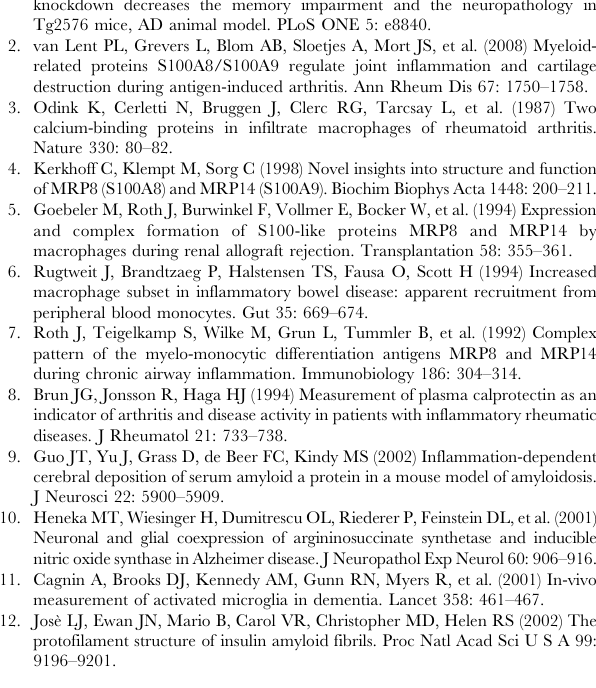
7.4 and 37 0 C for 3 d. The scale bars represent 500 nm, 1000 nm and 500 nm, respectively. (d) CD spectra of the corresponding samples shown in AFM: black squares correspond to Fig. (a); blue triangles correspond to Fig. (b); red circles correspond to Fig. (c). Figure S4 Measurements of NHSY5Y cell line viability by WST1 assay in the presence of (a): freshly dissolved A b 1–40 at pH 7.4. Different colors denote different concentrations of A b 1–40. (b): 0.2 mM A b 12–24 fibrils, 0.2 mM A b 1–40 fibrils and 0.2 mM A b 1–40 plaque. A b 1–40 plaques were formed by incubation at pH 3.0 and 37 0 C for 3 d. To avoid pH effect, pre-formed A b plaques were carefully dialyzed to pH 7.4. A b 12–24 and A b 1–40 fibrils were formed by incubation at pH 7.4 and 37 0 C for over 10 d. (c) The relationship between the kinetics of S100A9 amyloid formation (Relative ThT: left Y axis) at pH 3.0 and the effects of S100A9 (0.02 mM) on NHSY5Y cell viability (WST1 assay: right Y axis). Before mixing with cells, S100A9 was incubated at pH 3.0 and 4 0 C for up to 70 d. Aliquots were taken for measurements of ThT and cytotoxicity at different time during incubation. The columns in each group correspond to 1 to 3 d of incubation with cells (In day 6 aliquots, S100A9 samples were incubated with cell for up to 2 d). (d) Measurements of NHSY5Y cell line viability by WST1 assay in the presence of S100A9 (0.02 mM) at pH 7.4 and 3.0. Different colors denote 1 d to 3 d of incubation with cells. Figure S5 (a) Luminescent cytotoxicity assay of neuron cells in presence of 0.02 mM S100A9 and S100A9/A b 1–40 mixture. S100A9 and the mixture were incubated at 37 0 C for 3, 6, 12 and 24 h before mixing with cells. A b 1–40 plaques were formed by incubation at pH 3.0 and 37 0 C for 3 d. To avoid pH effect, pre- formed A b plaques were carefully dialyzed to pH 7.4 before mixing with S100A9. Utilizing cortical neuron cells, the CytoTox- AAF-Glo, to measure the activity of dead-cell protease, which is